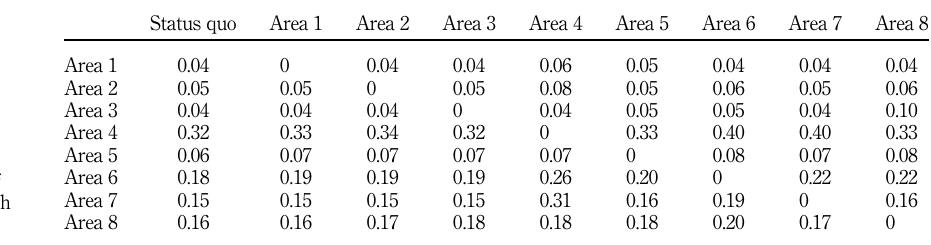
fishing effort with marine